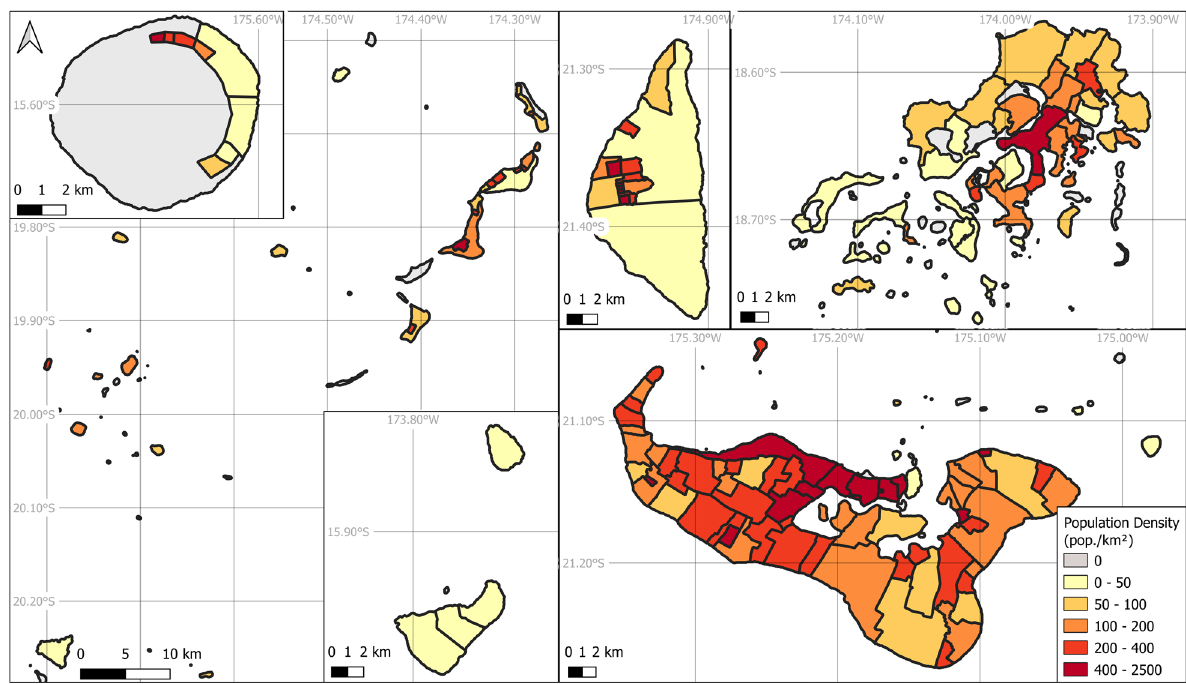
Fig. 2 Population density (pop./km 2 ) in Tonga by villages (TSD